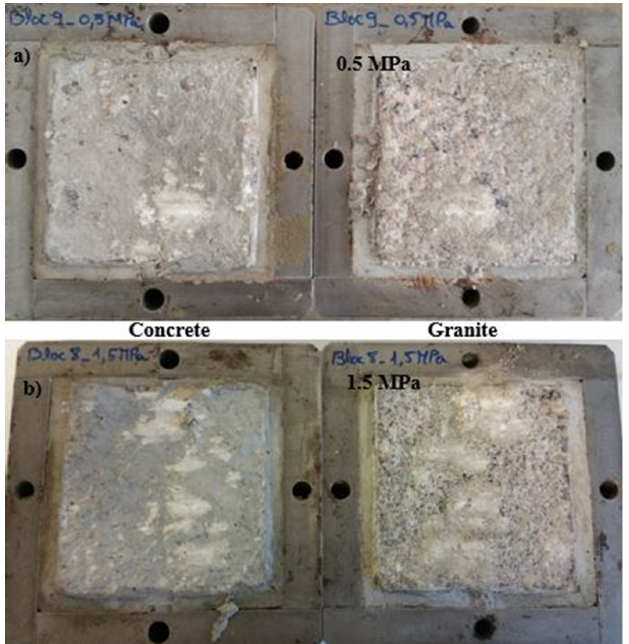
Figure 13. Failures behavior—natural granite interface. ( a ) Confinement stress 0.5 MPa: left-Concrete and right Granite; ( b ) Confinement stress 1.5 MPa: left-Concrete and right